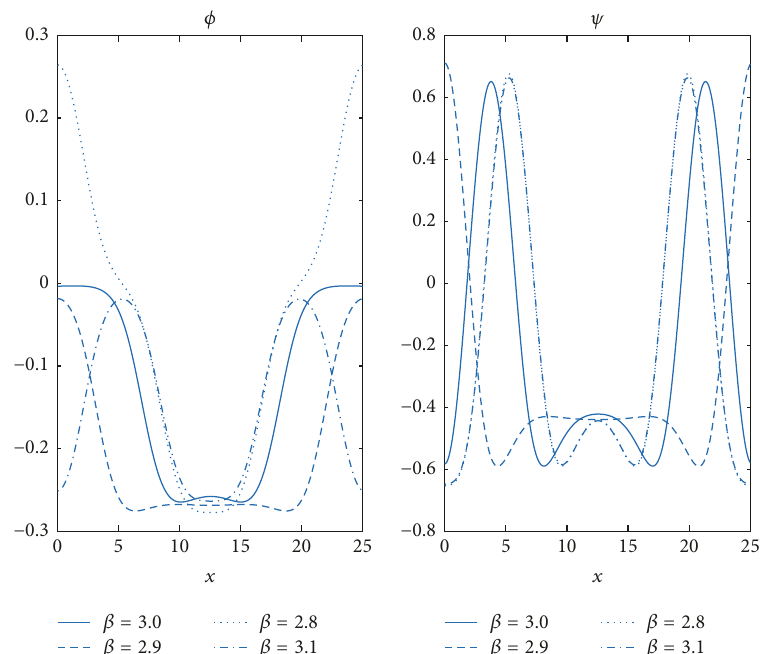
Figure 19: Comparison of periodic travelling wave solutions of the SBO system for different values of the parameter 𝛽